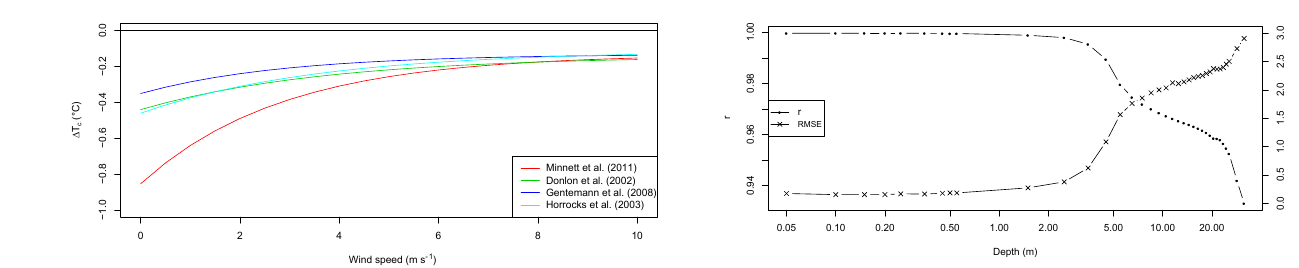
(Fig. 4b). At 10:00 UTC, around the time of satellite over- pass, the estimated average warm layer effect was 0.34 ◦